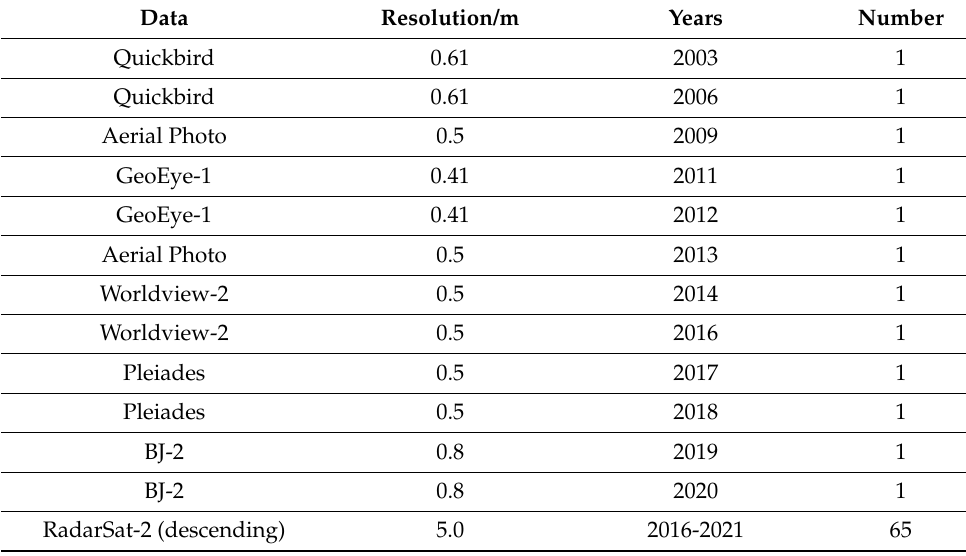
Figure 1. Geological Map of the Study Area. Table 1. Information of the images used in this